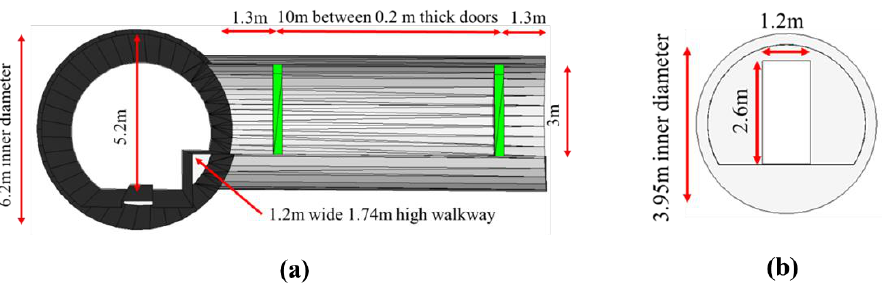
Figure 4. ( a ) Mesh sensitivity study using the gas temperature profile and ( b ) gas temperature profile comparison between experimental and numerical predictions along the long channel for the 0.75 MW diesel pool fire case.